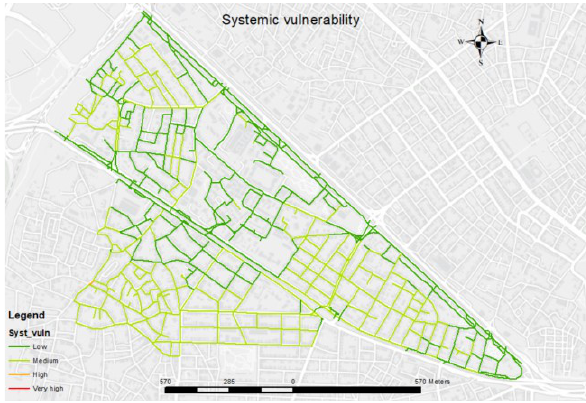
Figure 10 . Systemic vulnerability. Source: de Vries, 2022